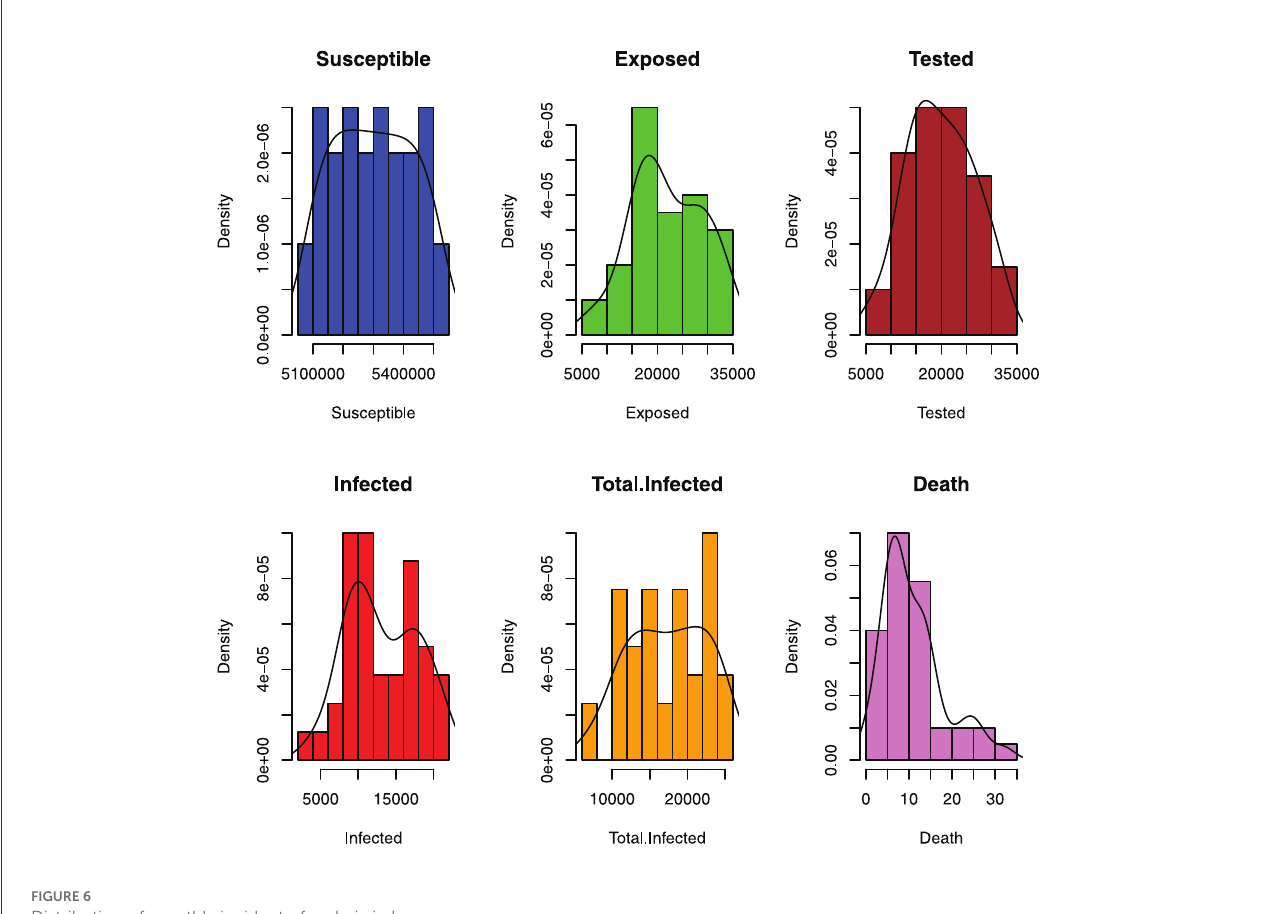
FIGURE6 Distribution of monthly incident of malaria in